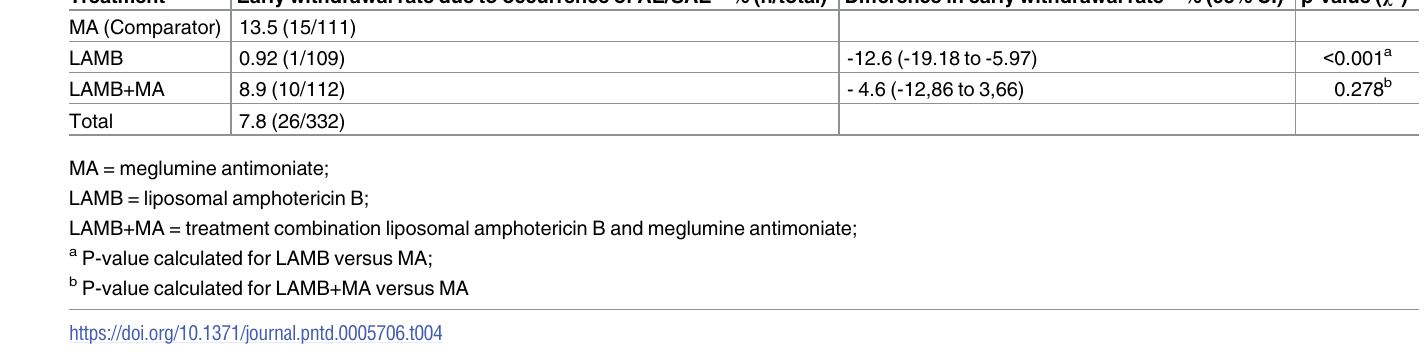
Table 4. Early withdrawal rate due to the occurrence of AE/SAE during treatment as per ITT.